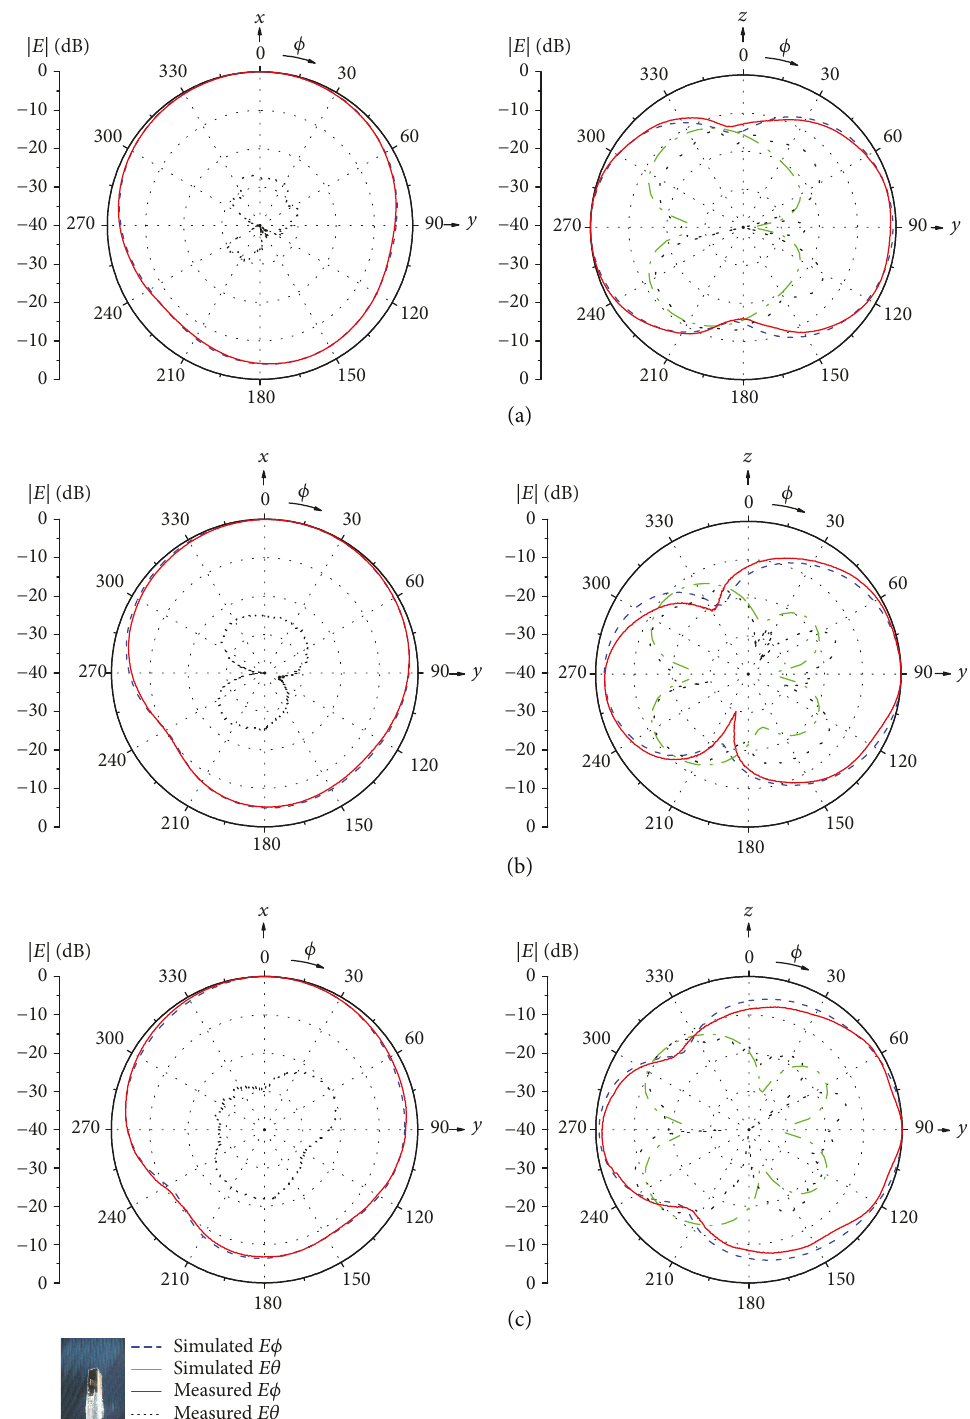
Figure 8: Measured and simulated radiation patterns of the wideband HP quasi-omnidirectional antenna at (a) 1.7GHz, (b) 2.2 GHz, and (c)